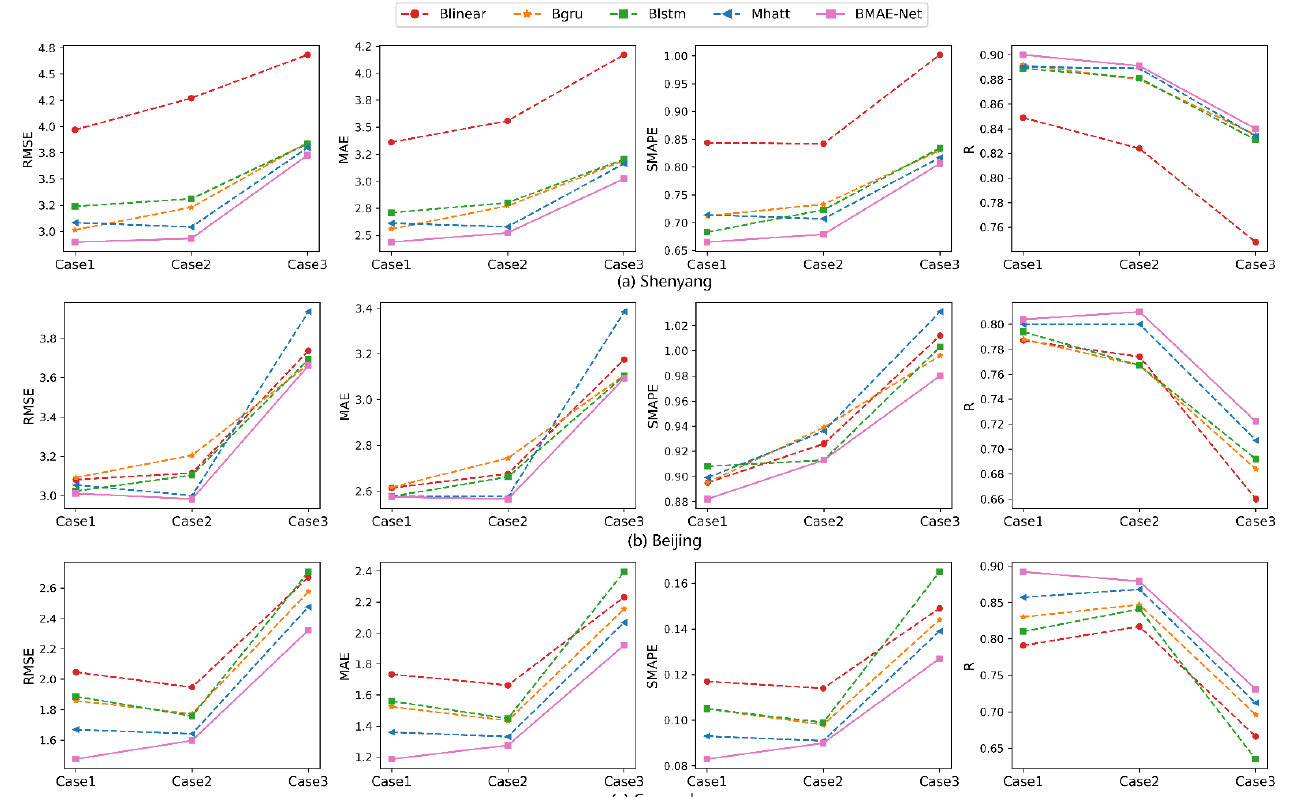
Figure 8. Line graphs of the three cases ’ temperature prediction evaluation metrics for each location. The x -axis indicates the three cases, and the y -axis indicates the evaluation index. The first three columns are error indicators. The smaller the value means, the better the model effect. The last column is the correlation indicator, the higher the value, the better the effect.